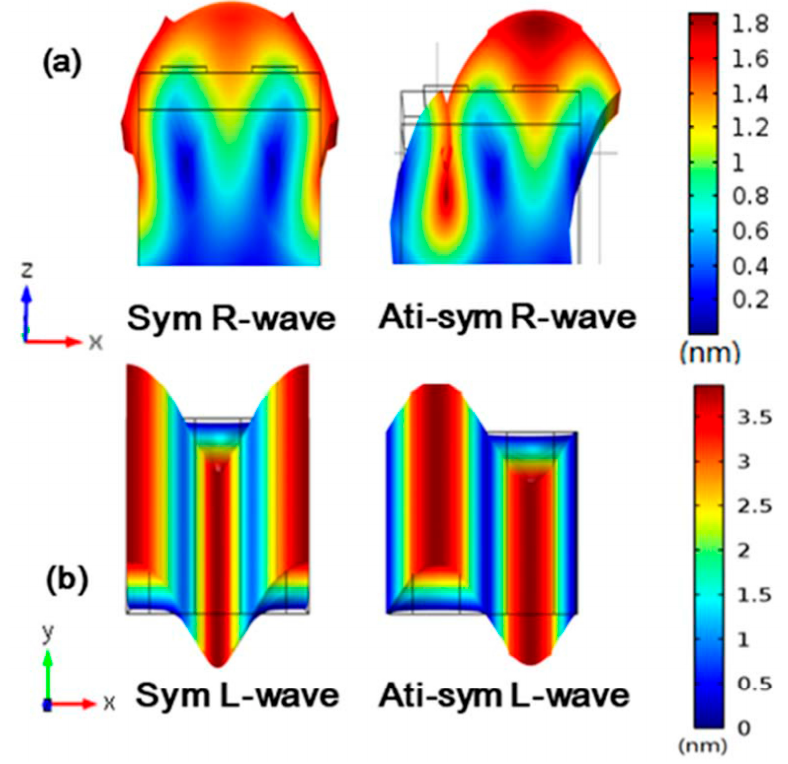
Figure 3. Displacement distributions in symmetric and anti-symmetric modes: ( a ) Raleigh wave; ( b ) Love wave.